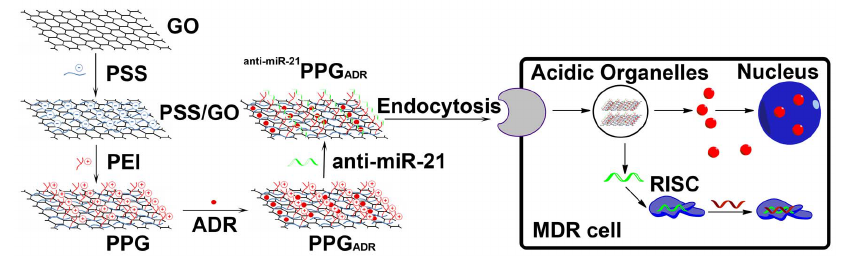
Figure 1. Schematic of the PPG fabrication and MDR reversion.